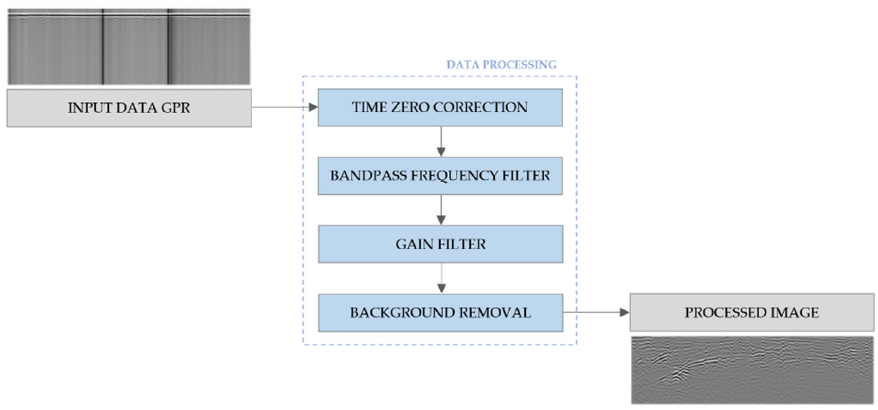
Figure 2. Diagram showing the stages of imagery pre-processing.